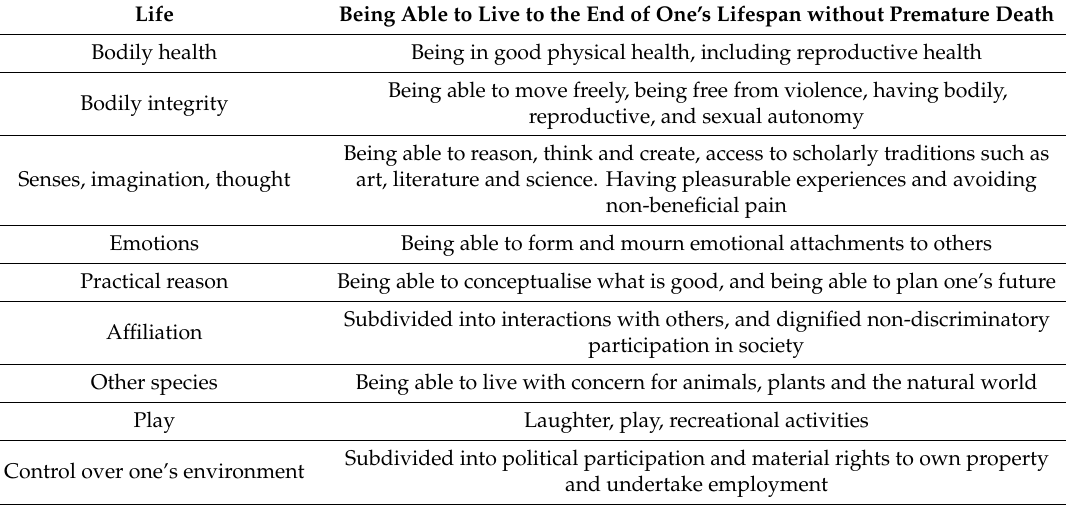
Table 1. Nussbaum’s 10 central human